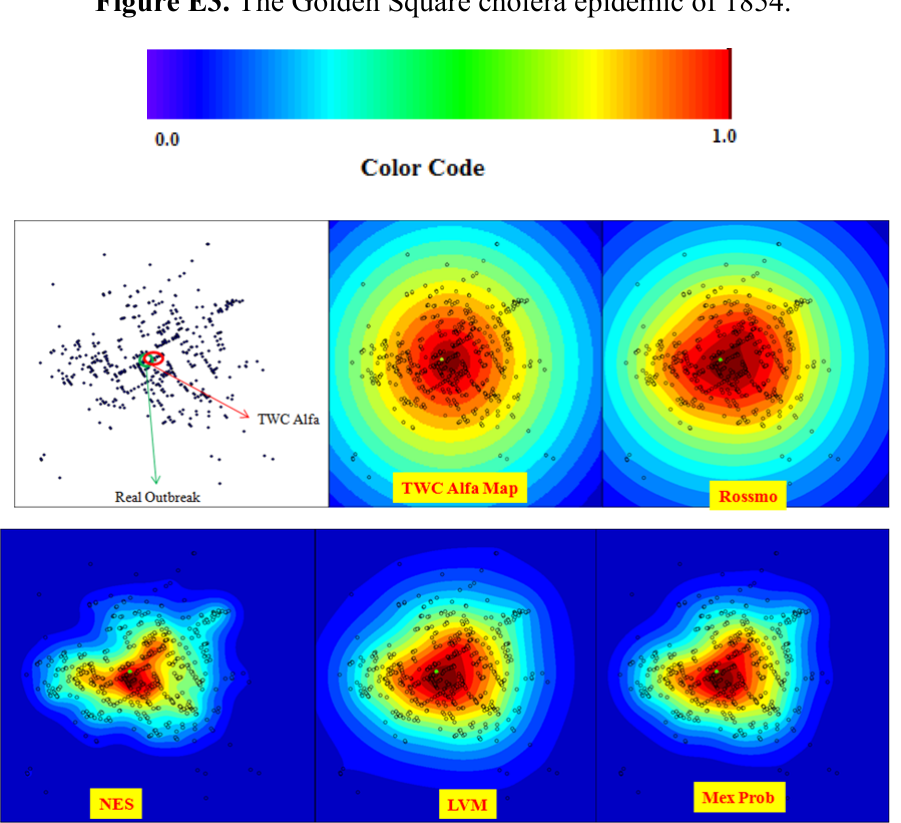
Figure E3. The Golden Square cholera epidemic of